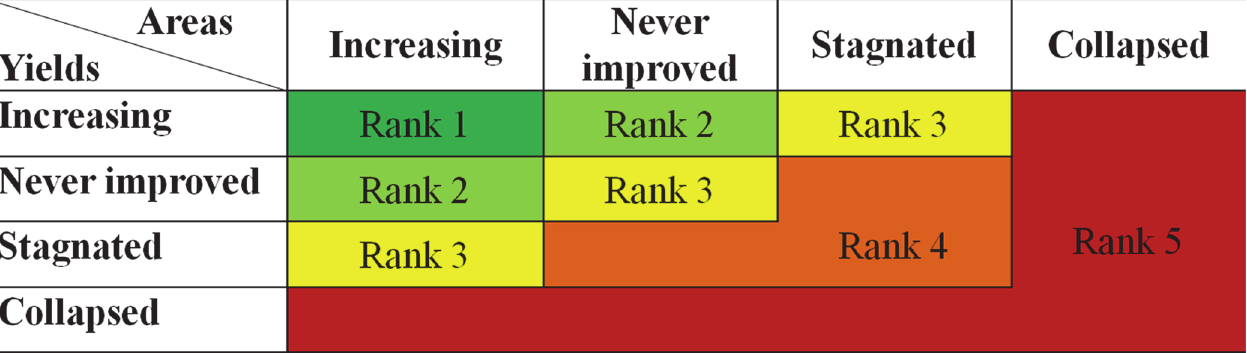
Fig 1. Identification matrix of food productivity sustainability ranks. Sustainability ranks based on yield-area trend relationships. Ranks diagonally increase from 1 to 5, suggesting decreasing sustainability of food productivity.